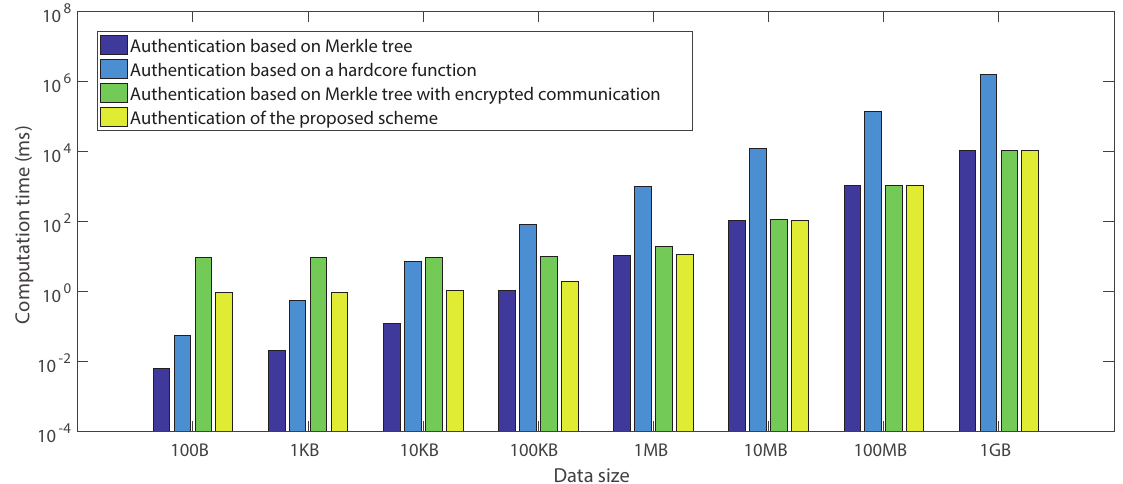
Figure 9. Comparison of computation overhead on the prover side.